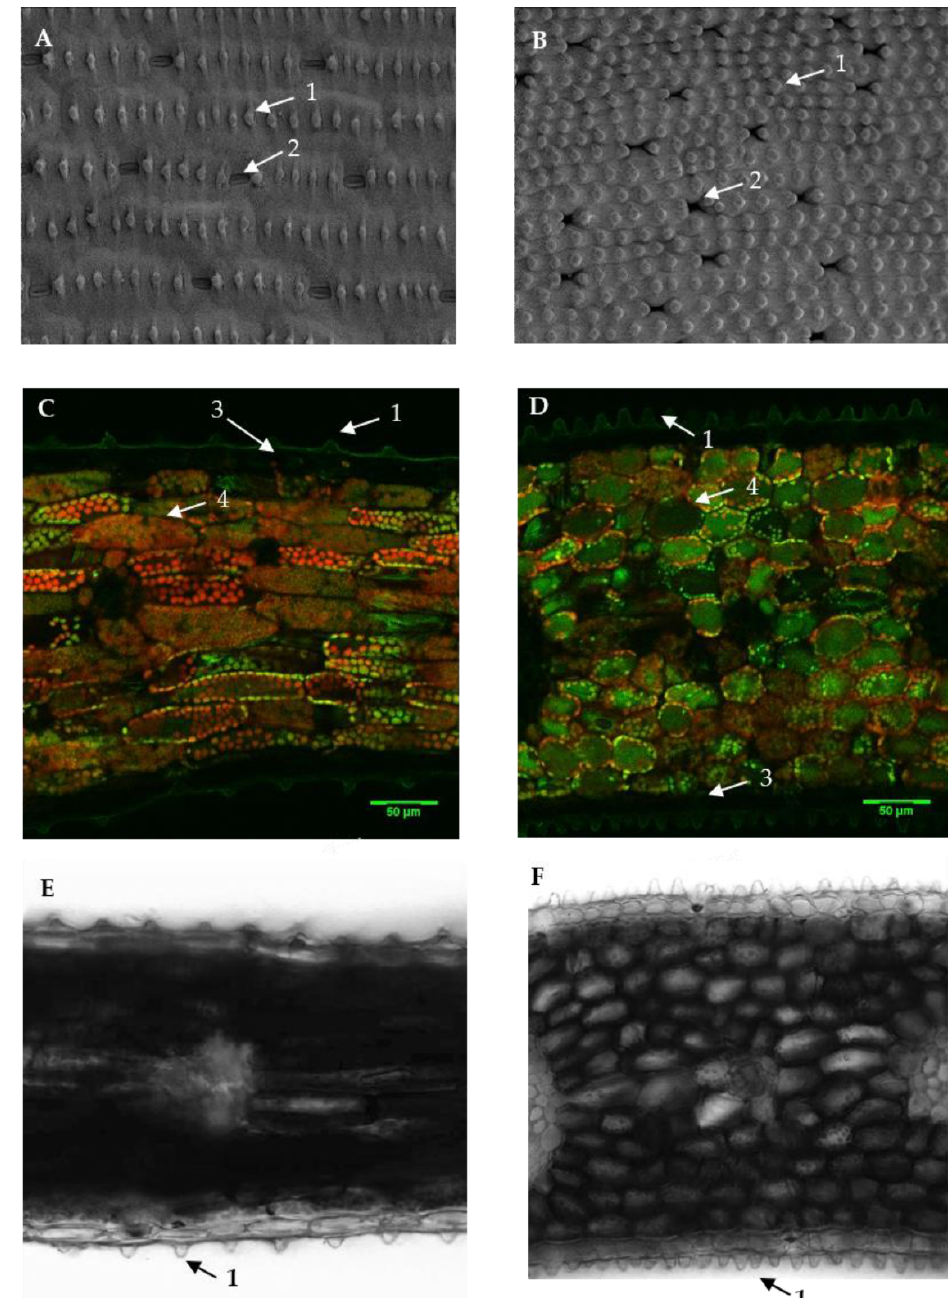
Figure 4. Leaf surface scanning electron photomicrographs of the thrips-susceptible Gladiolus variety Charming Beauty ( A ) and the thrips-resistant variety Robinetta ( B ). Lead cross sections of Charming Beauty ( C ) and Robinetta ( D ) with confocal laser scanning. Leaf cross sections of Charming Beauty ( E ) and Robinetta ( F ) with visual light microscopy. Arrows indicate papillae (1), stomata (2), epidermal cells, (3) and mesophyll (4).